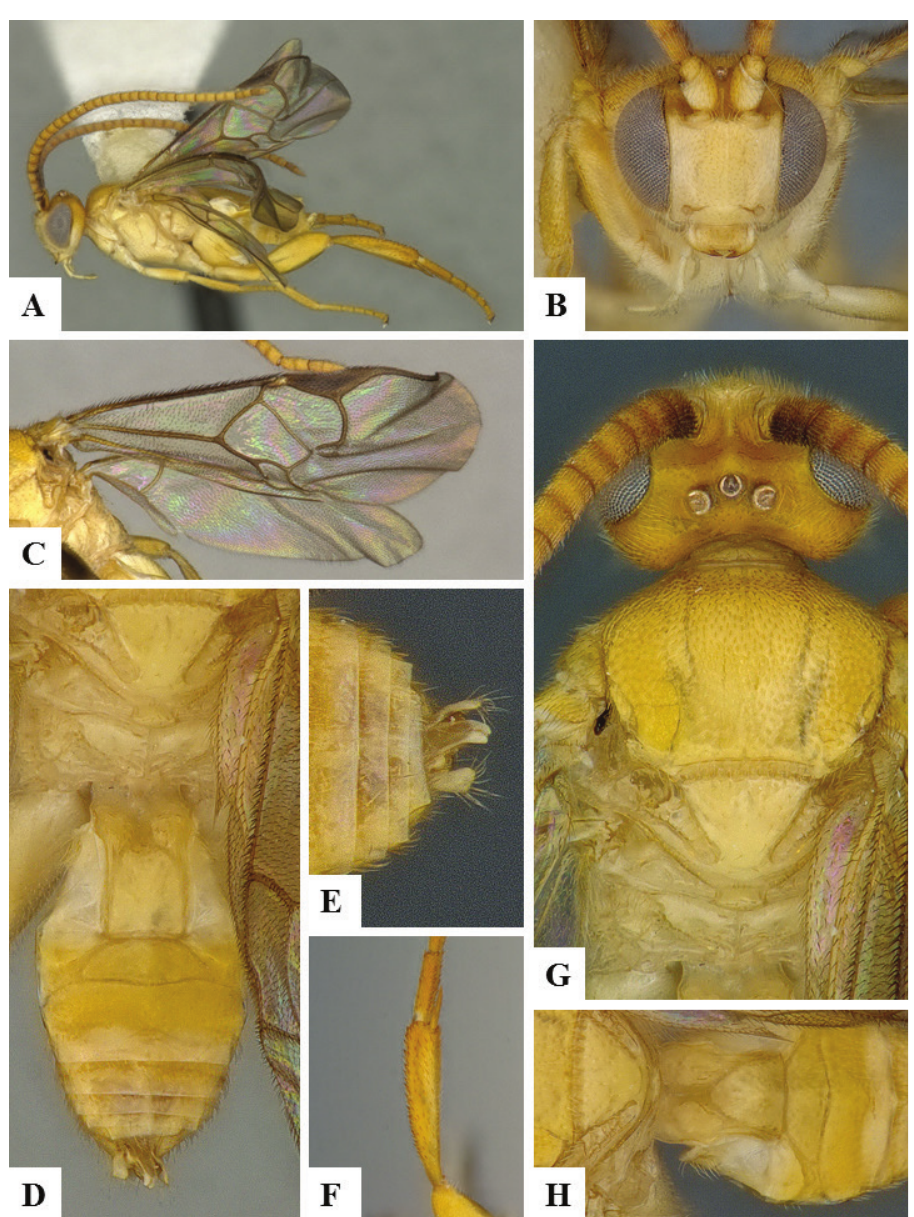
Figure 45. Ypsilonigaster zuparkoi male holotype. A Habitus B Head frontal C Fore wing and hind wing D Metasoma dorsal E Genitalia F Metatibia G Head and mesosoma, dorsal H Tergites 1 to 2. a strong sulcus shaped as an inverted “Y”; T1 L 2.00–2.41 × T1 width at posterior margin. T2 subtriangular; T2 width at posterior margin 2.95–3.47 × T2 L. Body measurements (mm). F2 L: 0.26 (0.26); F3 L: 0.26 (0.26); F14 L: 0.22 (0.23); F15